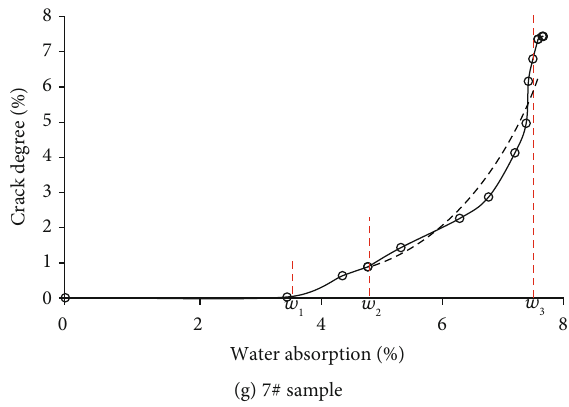
Figure 15: Relationship curves of crack degree and water absorption of 1# ~ 7# samples. Table 4: Characteristic values of water absorptions and fi tting